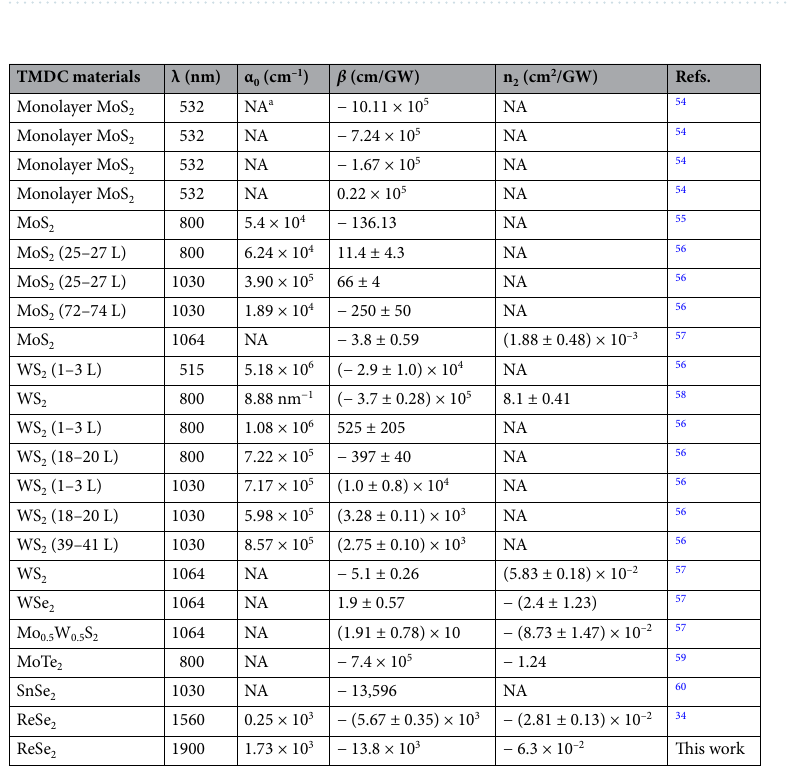
Table 1. Comparison of the nonlinear optical parameters of various TMDCs. NA not